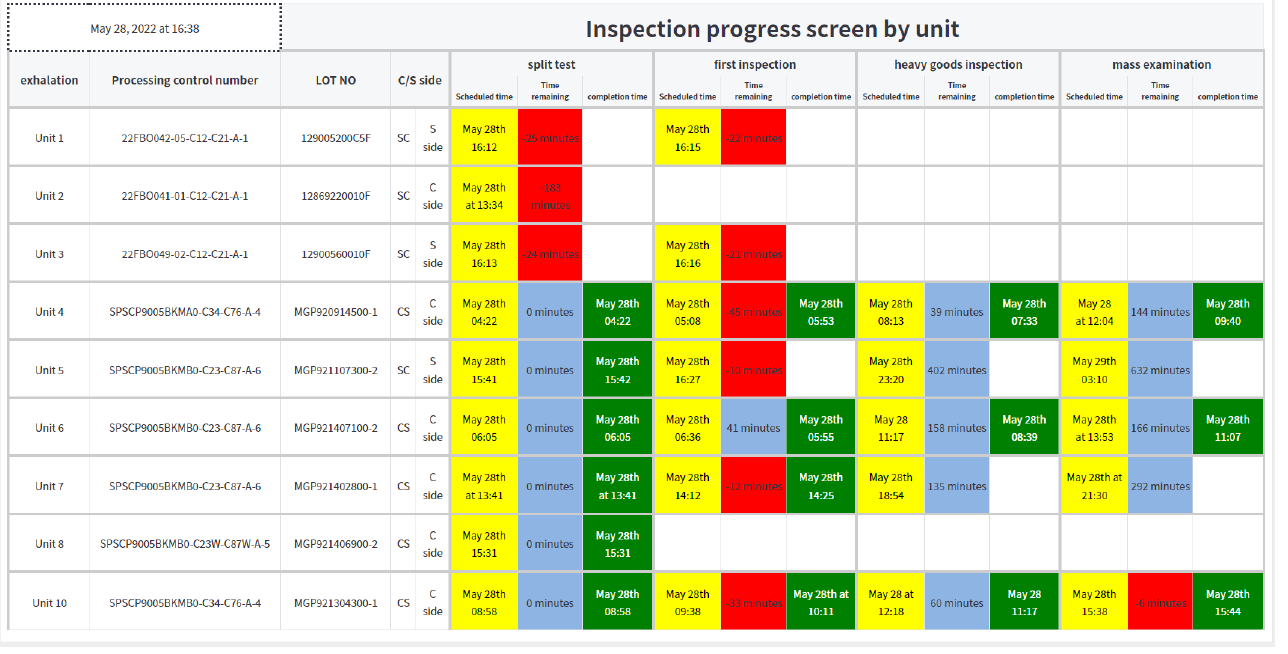
Figure 19. The inspection process of the HCPS